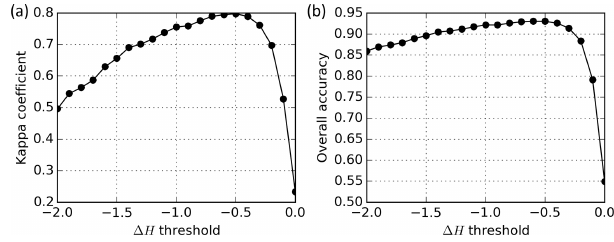
Figure 9. Kappa coefficient (a) and overall accuracy (b) obtained from the comparison between the data surveyed by Yamada et al. (2017) and the estimated collapsed buildings based on different (cid:49)H threshold